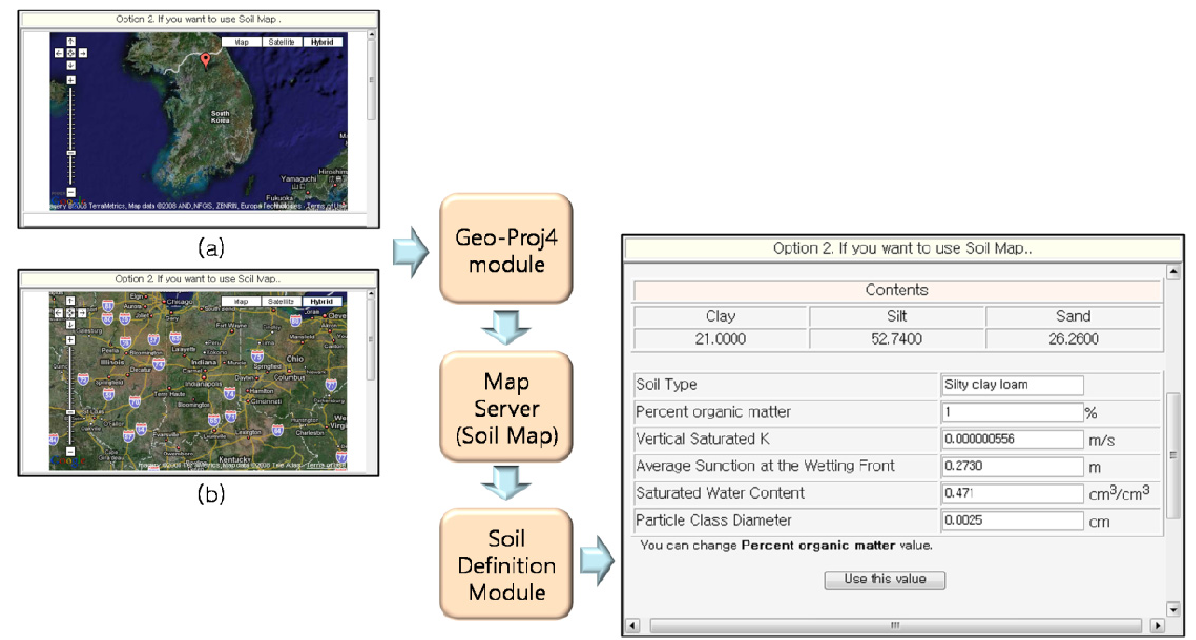
Figure 5. Google Map interface for extracting various soil input parameters; ( a ) South Korea; ( b ) AL, IN, IL, KY, MI, MS, TN, and WI,